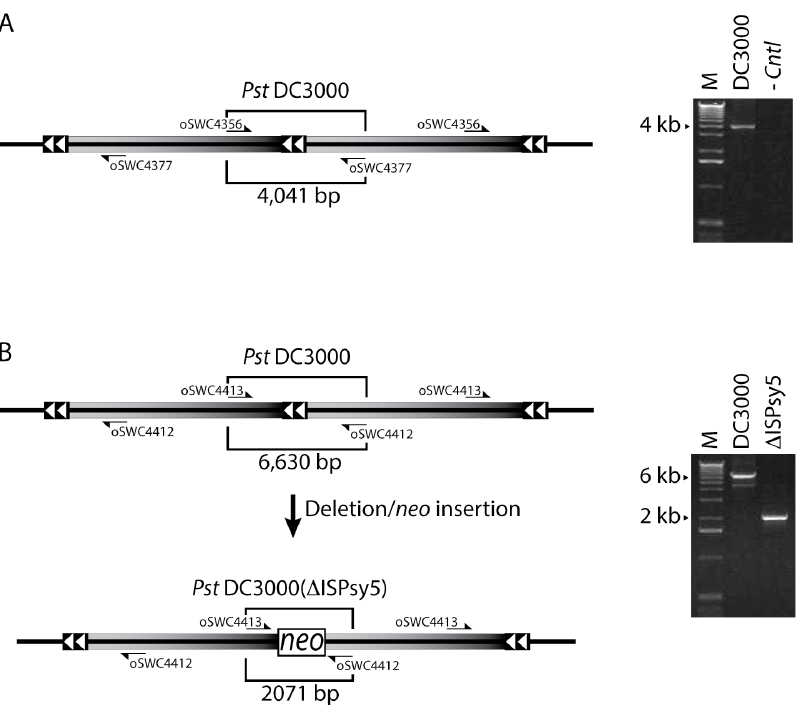
Figure 2. The 165 kb region is a tandem duplication. Each copy of the 165 kb duplicated region is depicted as a rectangle shaded with gray- to-black gradient. The duplicated sequences are flanked by ISPsy5 elements, which are depicted by two white triangles. A. PCR with oSWC4356 and oSWC4377 generate a 4041 bp product when using Pst DC3000(H0457) genomic DNA as template. No product is generated using the same primers when genomic DNA from a Pst DC3000 isolate lacking the duplication (see below) was used as template (-Cntl). B. The central ISPsy5 element was deleted and replaced with the kanamycin resistance encoding neo gene using recombineering. PCR with primers flanking this locus (oSWC4412 and oSWC4413) generate a 6630 bp product when the ISPsy5 element is present and a 2071 bp product in cells where the neo gene has replaced the central ISPsy5 element. PCR products were resolved on 1% agarose gel and migration in the predicted size range. M, indicates molecular weight marker.